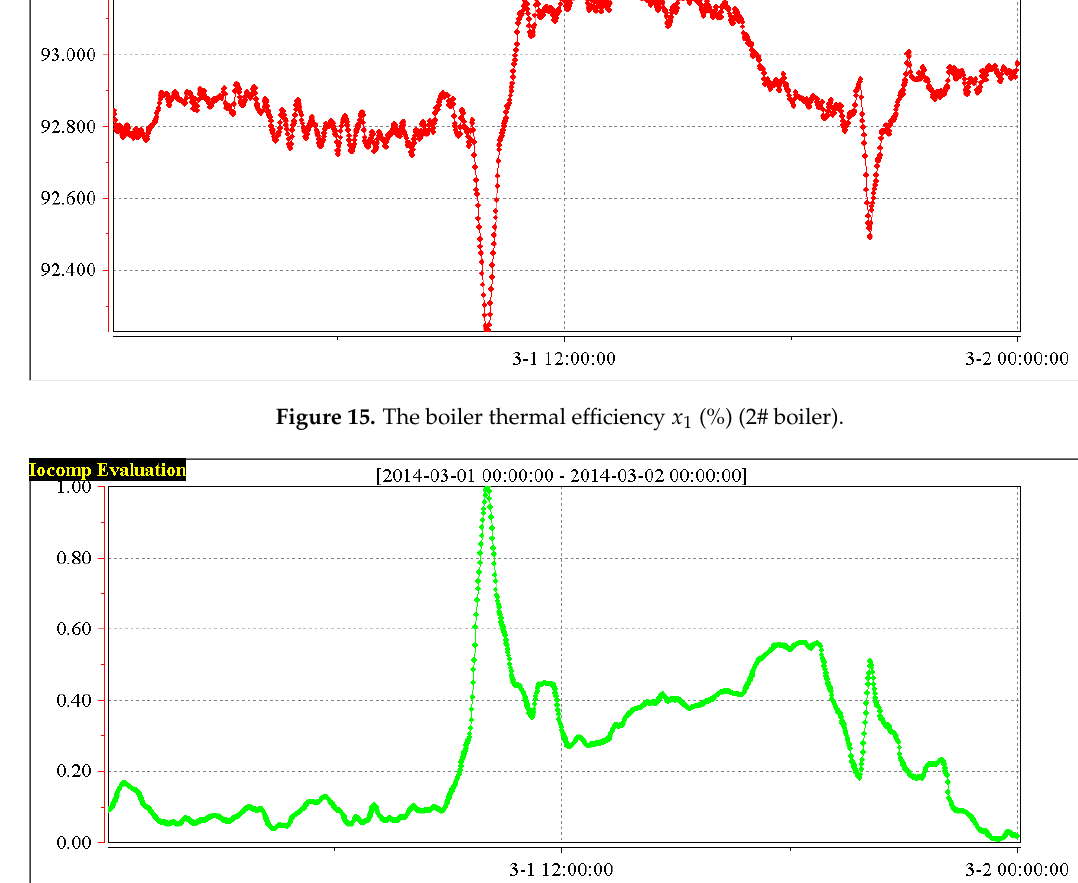
Figure 16. The flue gas temperature x 2 ( ◦ C) (2# boiler).